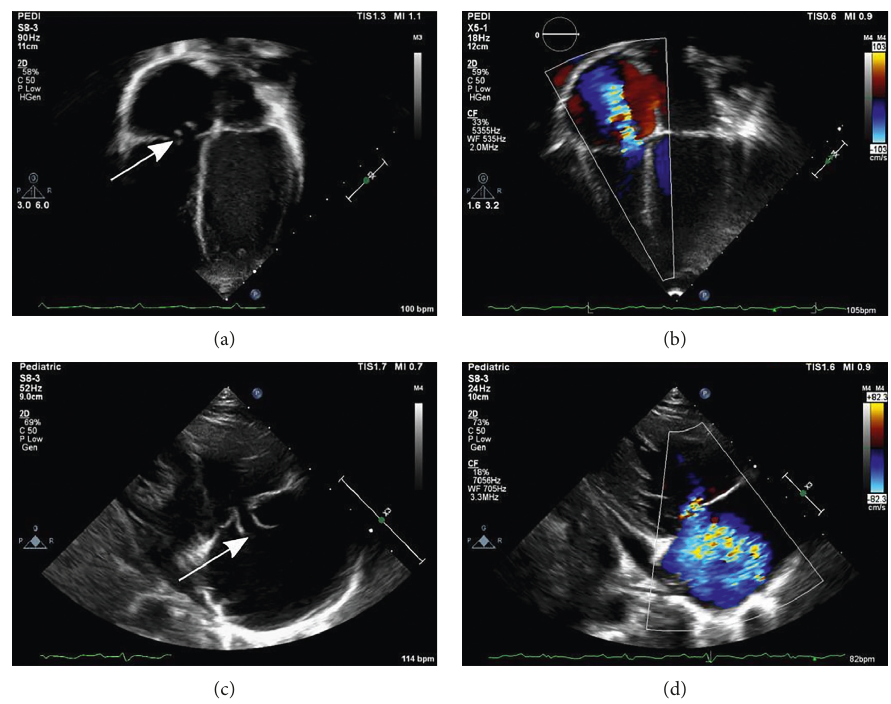
Figure 1: Echocardiogram showing echocardiographic clips: (a) two-dimensional apical 4-chamber view showing tricuspid valve leaflet perforation (arrow) with possible chordal disruption, (b) color Doppler image of apical 4-chamber view showing tricuspid regurgitation (blue jet), (c) two-dimensional parasternal long-axis view showing tricuspid valve leaflet perforation (arrow), and (d) color Doppler image of parasternal long-axis view showing tricuspid regurgitation (blue